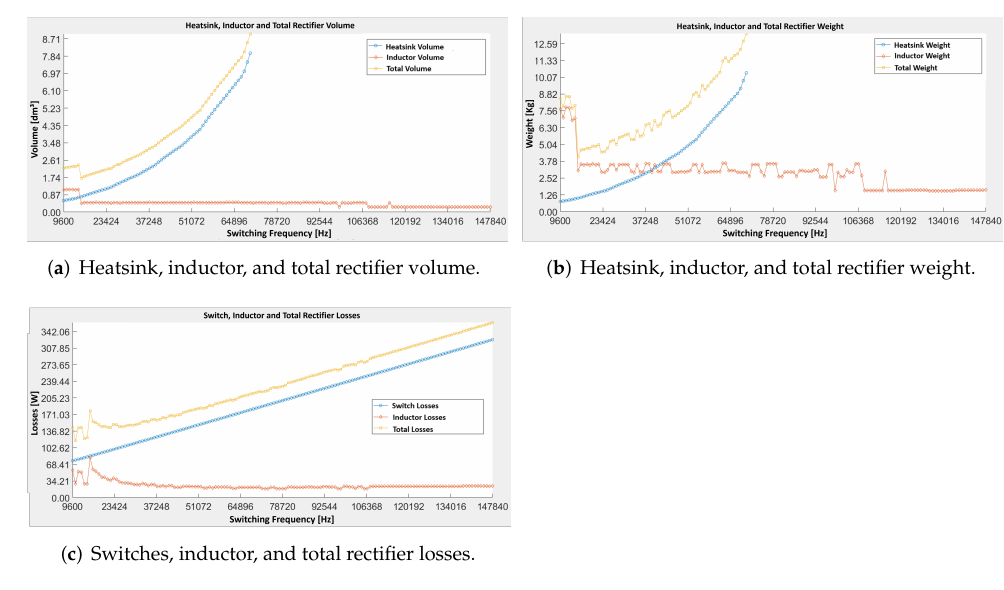
Figure 6. Rectifier volume, weight, and loss